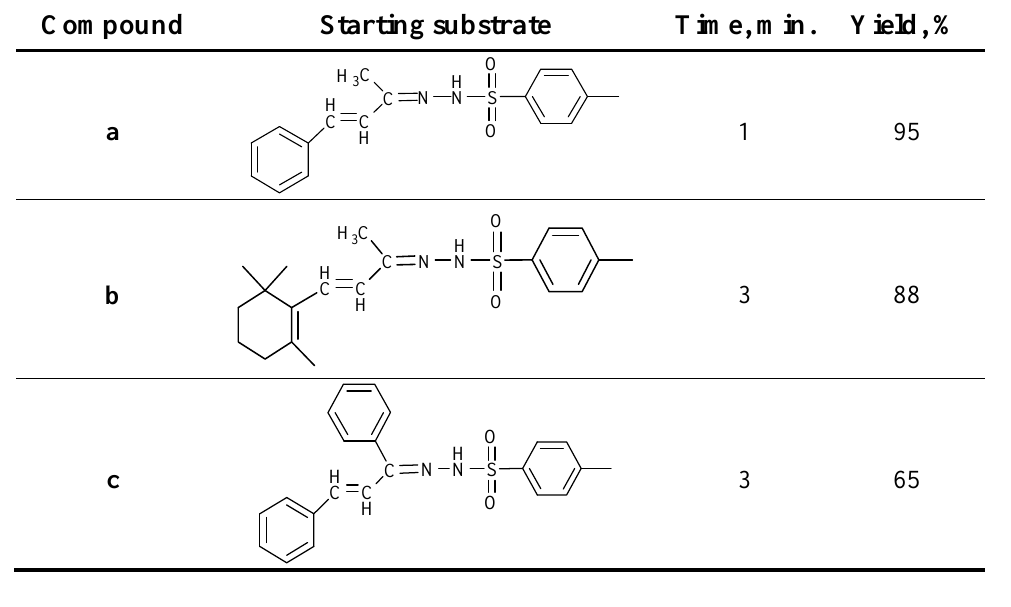
Table 3. Solvent free microwave-mediated synthesis (MW1) of compounds a-c under the best catalytic conditions (entry F – Table 2) from tosylhydrazones. Compound Starting substrate